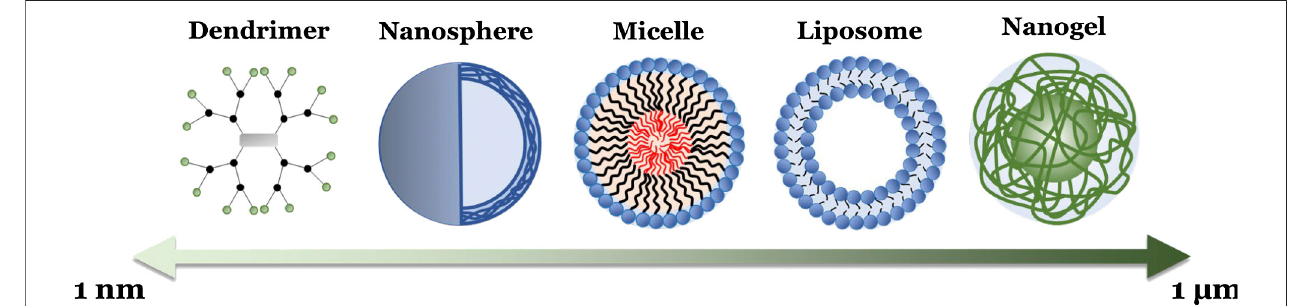
FIGURE 4 | Schematic illustration of the different polymeric NP formulations, with their relative sizes, summarized in Box 1 .